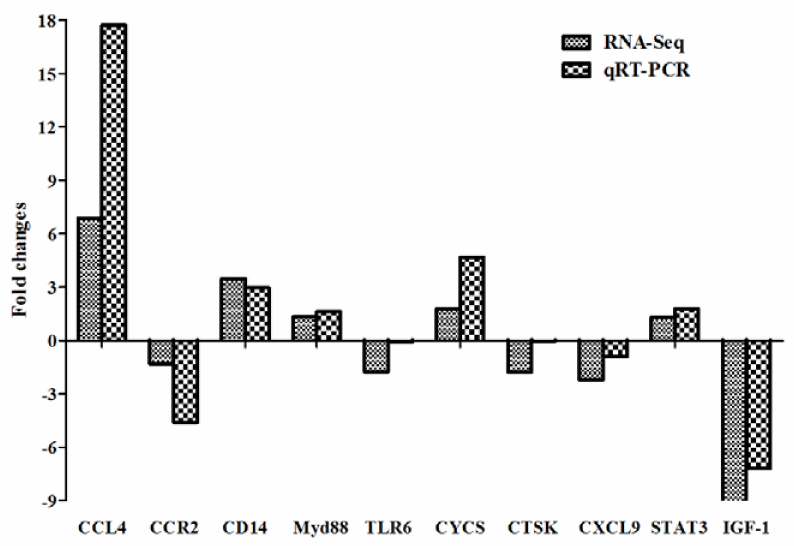
Figure 6. Relative quantification of DEGs for verification by RT-PCR. RT-PCR relative expression levels of selected genes were chosen for the cells infected for 24